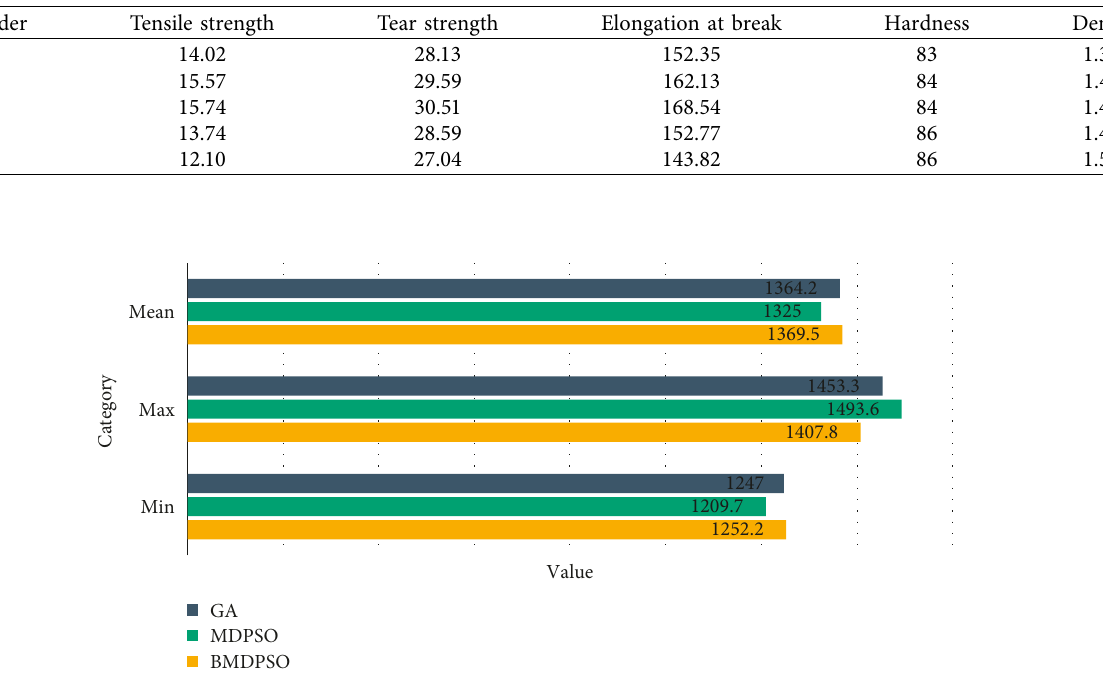
Figure 7: Comparison of algorithm running results.